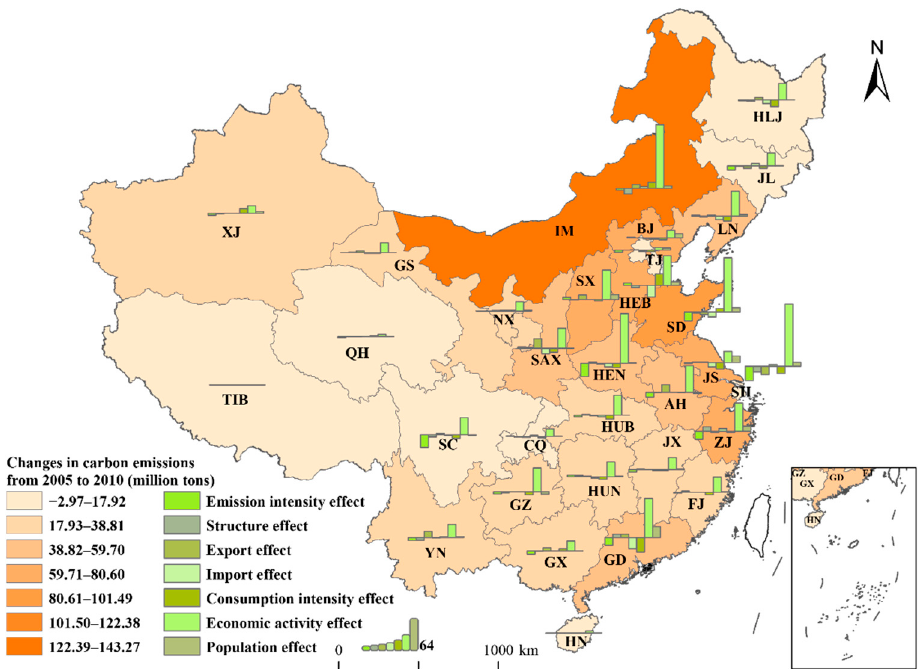
Figure 7. Provincial changes in carbon emissions and driving forces during 2005–2010.